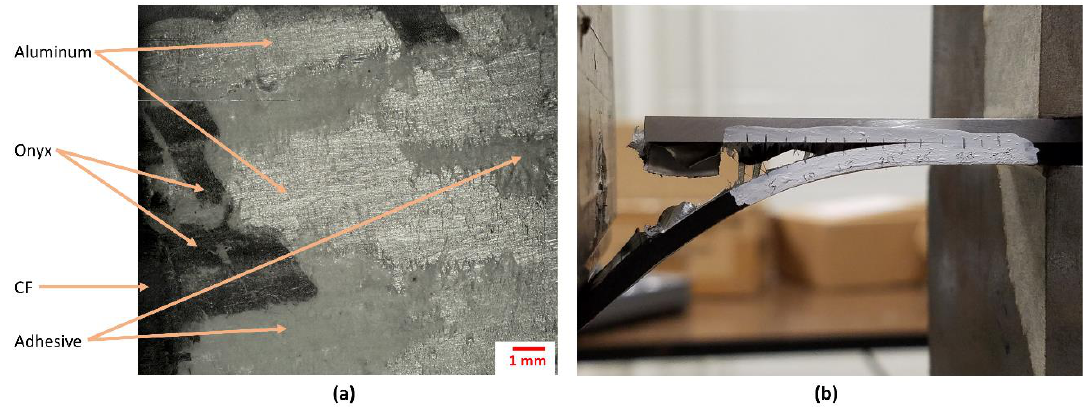
Figure 8. ( a ) Micrograph of the debonded face following the single cantilever beam (SCB) testing, where some residual ONYX and adhesive remained attached to the metal layer and ( b ) Sample during SCB testing.